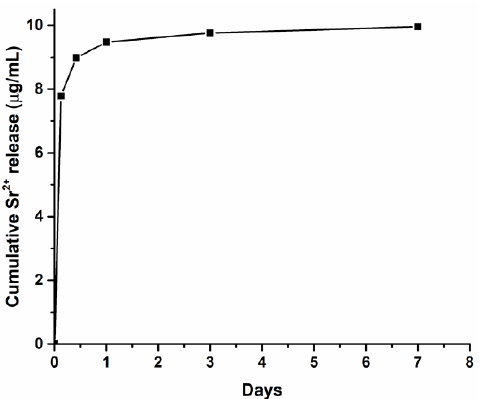
Figure 7. Ion release profile obtained for GEN-Coll/MBG_Sr4% sample throughout 7 days of incubation, measured at specific time points.